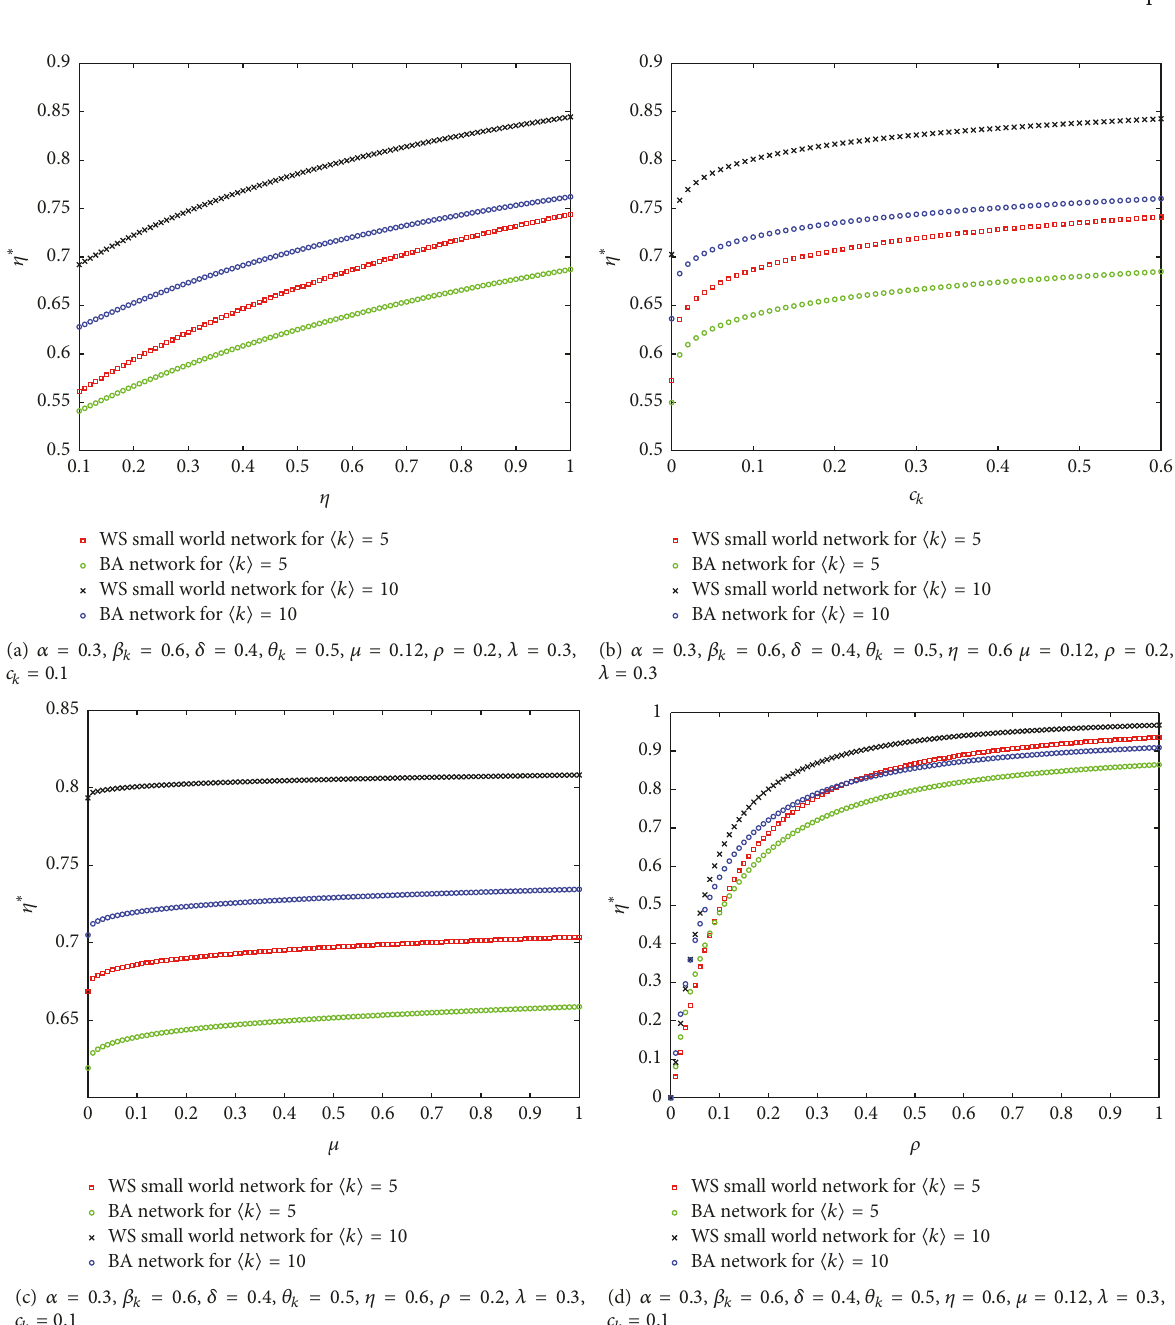
Figure 1: The evolution function of the equilibrium point 𝜂 ∗ of credit risk contagion system as function in the initial fitness 𝜂 of credit risk contagion, the emotional disturbance probability 𝑐 𝑘 of investor, the spillover effect 𝜇 of credit risk contagion of infected investor, and the malicious attack strength 𝜌 of some institutional investors under the different network